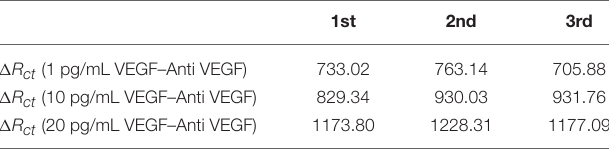
TABLE 4 | The normalized 1 R ct a function of VEGF